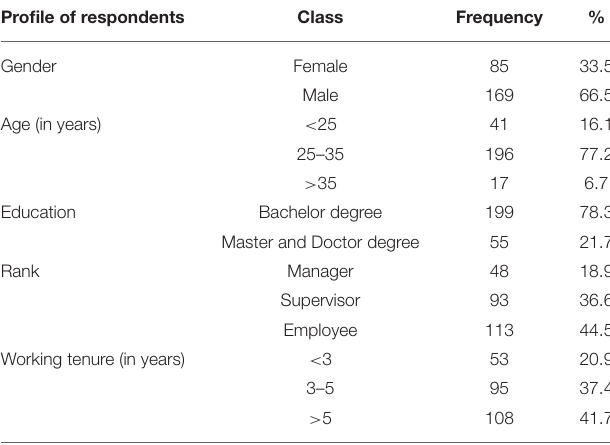
TABLE 2 | Description of the sample ( N =